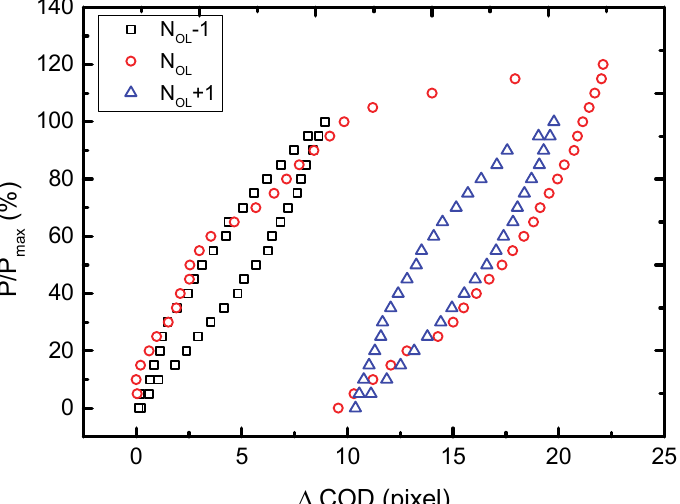
Figure 5: The evolution of COD at the crack wake at OL-1, OL and OL+1 cycles (data points are extracted from the measurement with a distance of 50  m behind the crack tip)